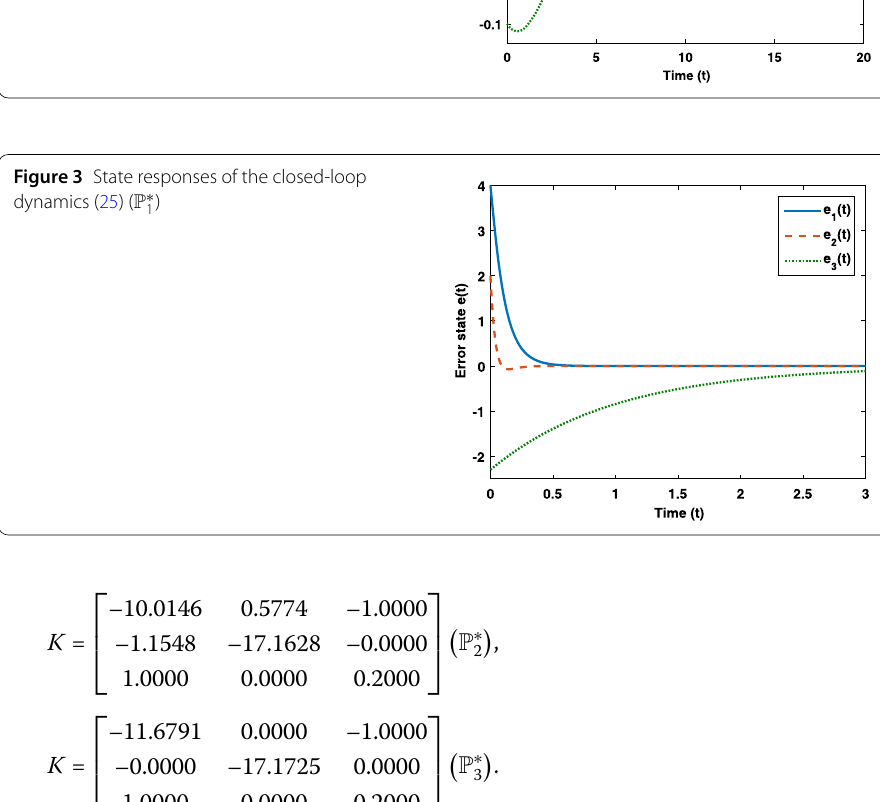
Figure 2 State responses of the closed-loop dynamics (7) ( P ∗ 2 )